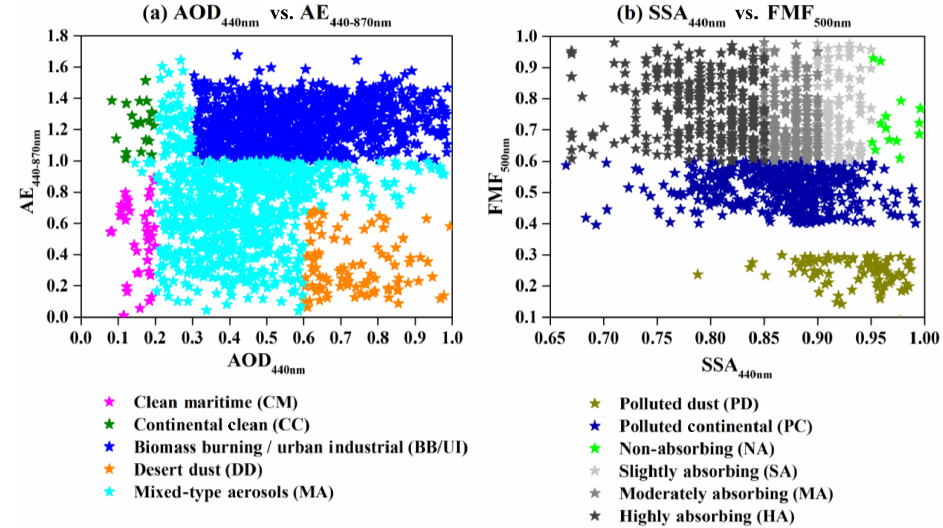
Figure 3. Classification of aerosol types based on different thresholds of (a) AOD 440nm vs. AE 440 − 870nm and (b) SSA 440nm vs. FMF 500nm .